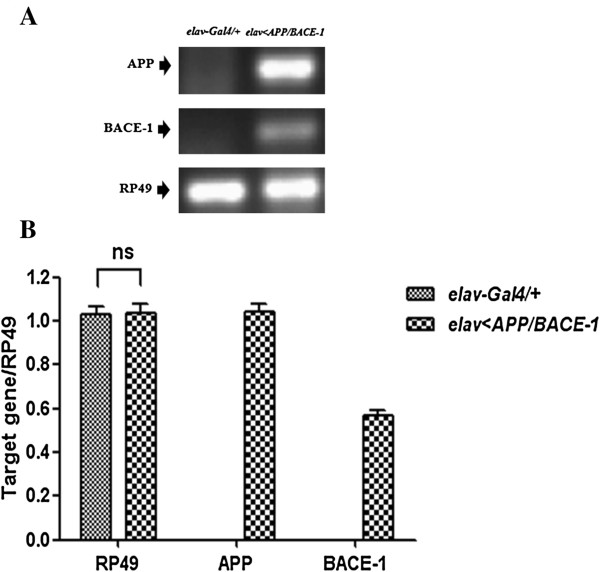
mRNA expression level of transgenic flies, elav-Gal4/+ as control fly. Target gene human APP and BACE-1 electrophoresis results (A) and semi-quantitative RT-PCR analysis of human APP and BACE-1 genes mRNA expression level (B). Gene RP49 was used as the reference gene to normalize mRNA amount. For RP49 mRNA expression amount, there was no significant difference between control flies and transgenic flies, however, mRNA of target genes human APP and BACE-1 were not expressed in control flies. ns: no significant difference. Each bar represents standard error.